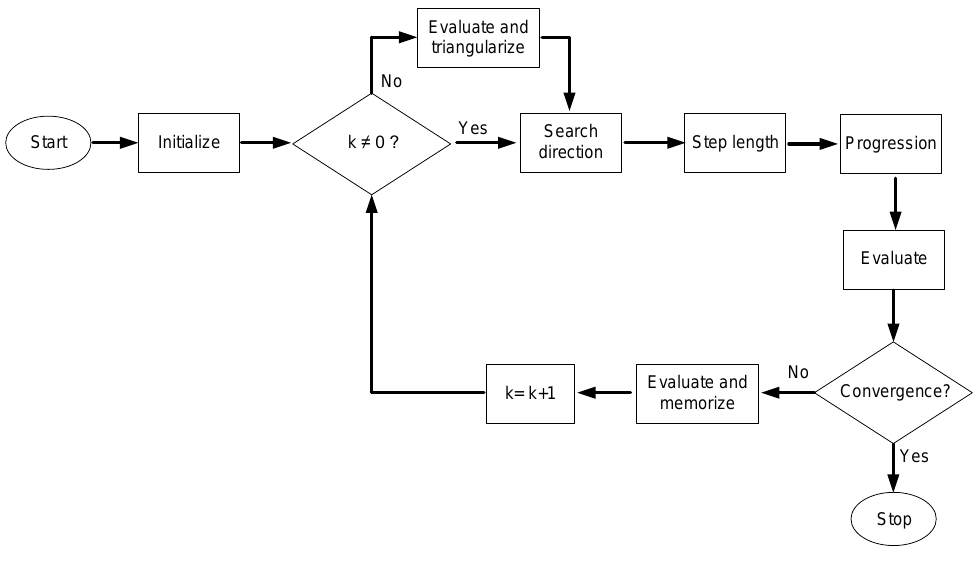
Figure 2. Flowchart of the Quasi-Newton method.